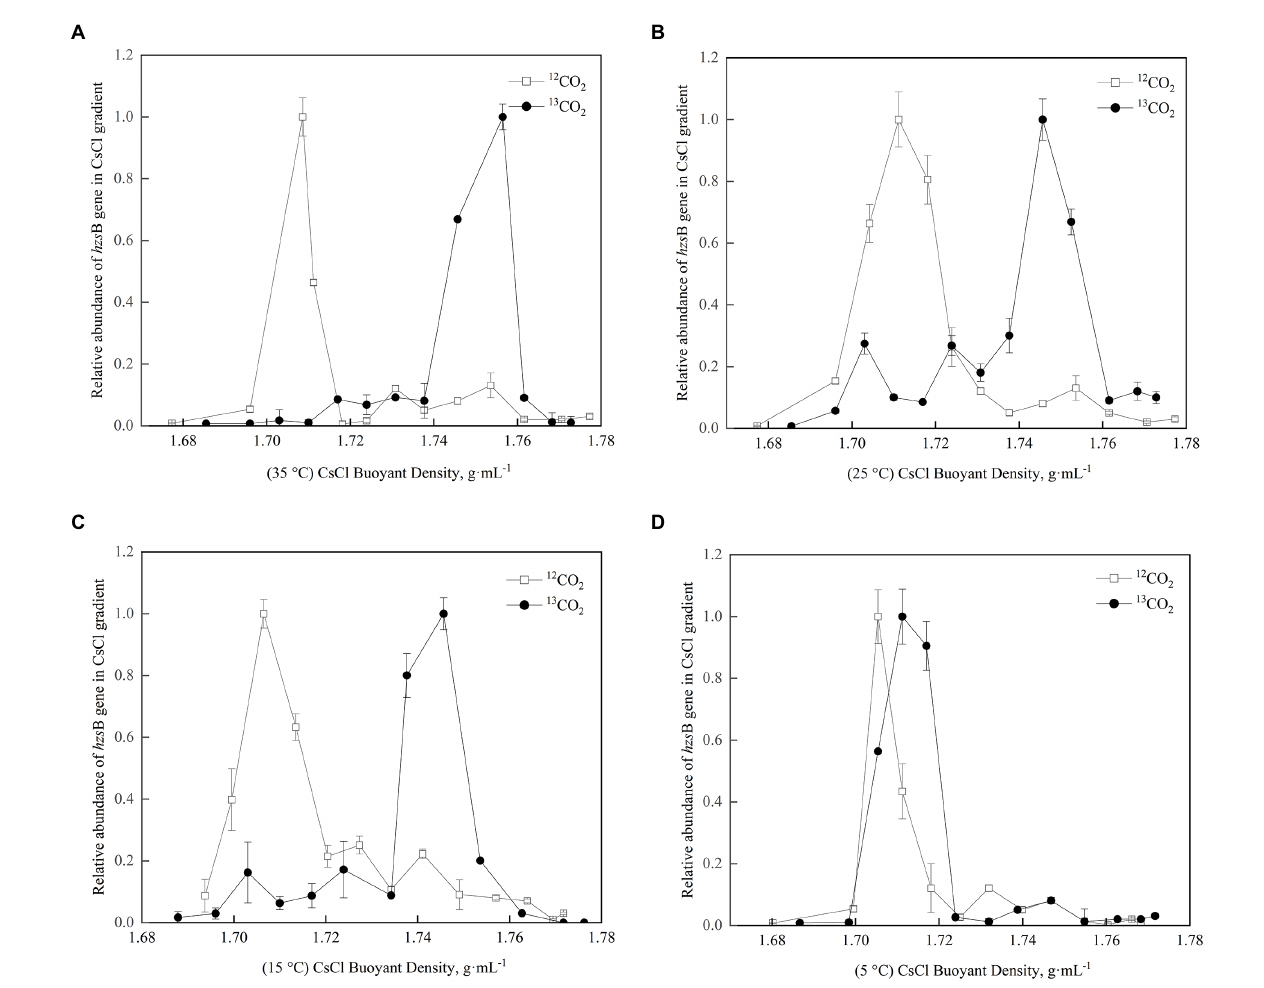
FIGURE 2 Quantitative distribution of the anammox bacteria hzsB genes across the entire buoyant density gradient of the DNA fractions in different treatments. (A) is 35°C; (B) is 25°C; (C) is 15°C; (D) is 5°C. Different letters mean significant differences among the treatments ( p ≤ 0.05, n = 3).